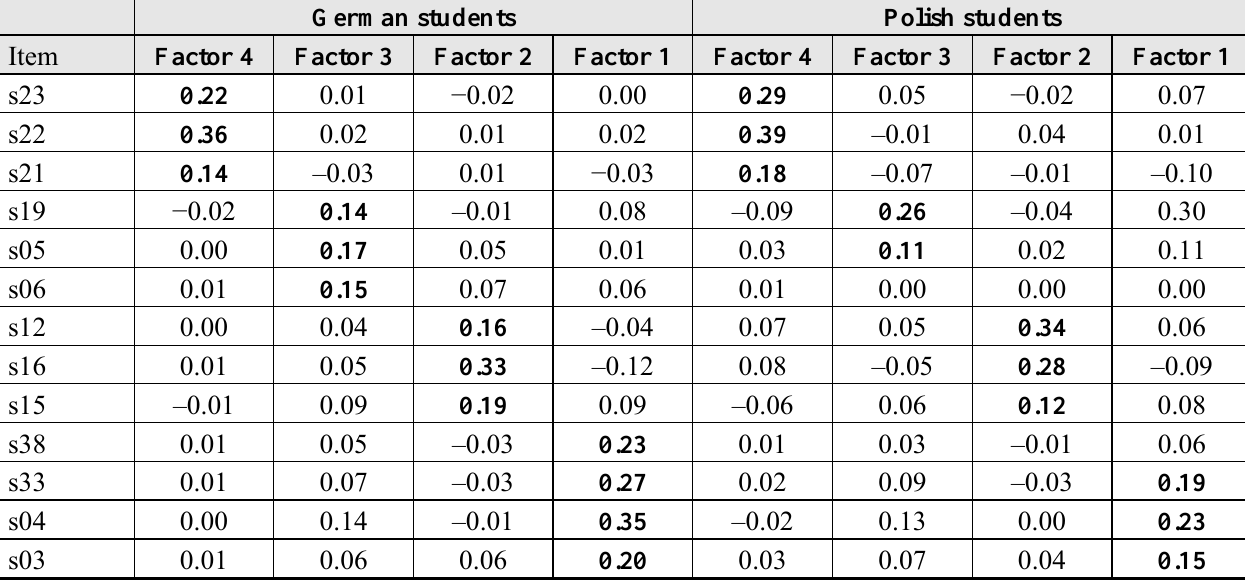
Table 4. Confirmatory factor loading: Classification of items to the established factors.